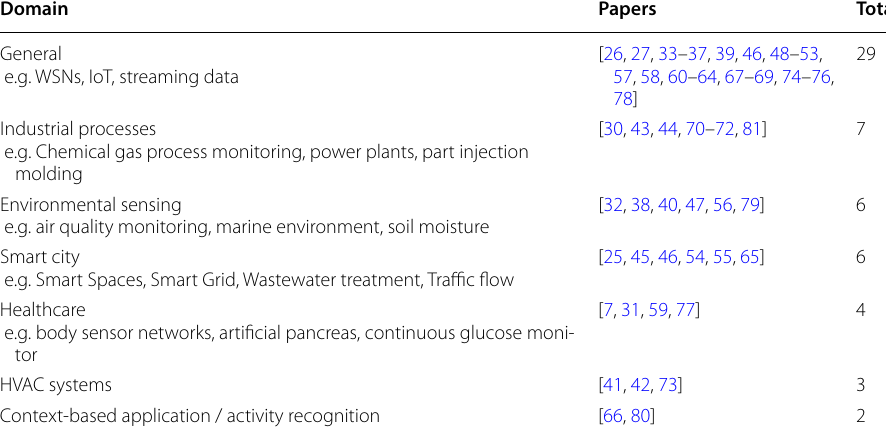
Table 6 Domains of sensor data quality application from the 57 selected papers, along with its respective papers and total number of papers that solve sensor data errors in that